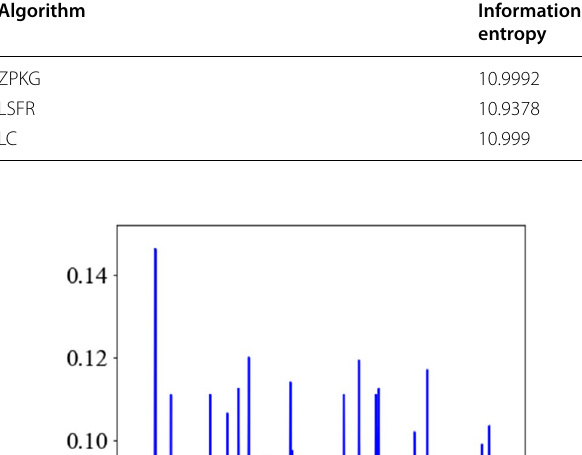
Fig. 7 Time cost for generating the